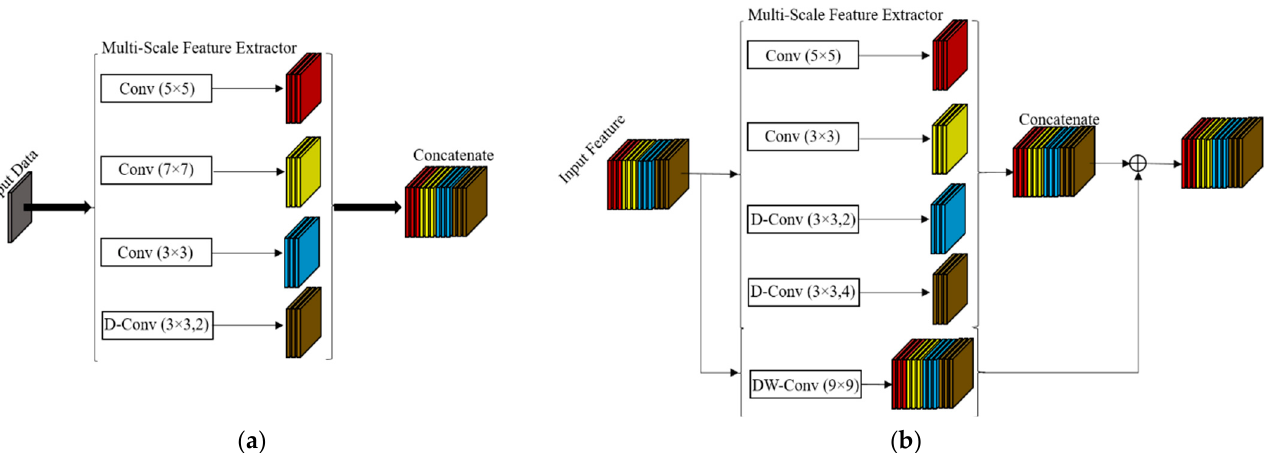
Figure 6. ( a ) Mechanism of Multi-scale Block, ( b ) Mechanism of Multi-scale Residual Dilated Convolution Block. Convolution (Conv), Dilated-Convolution (D-Conv), Depth-wise convolution (DW-Conv).